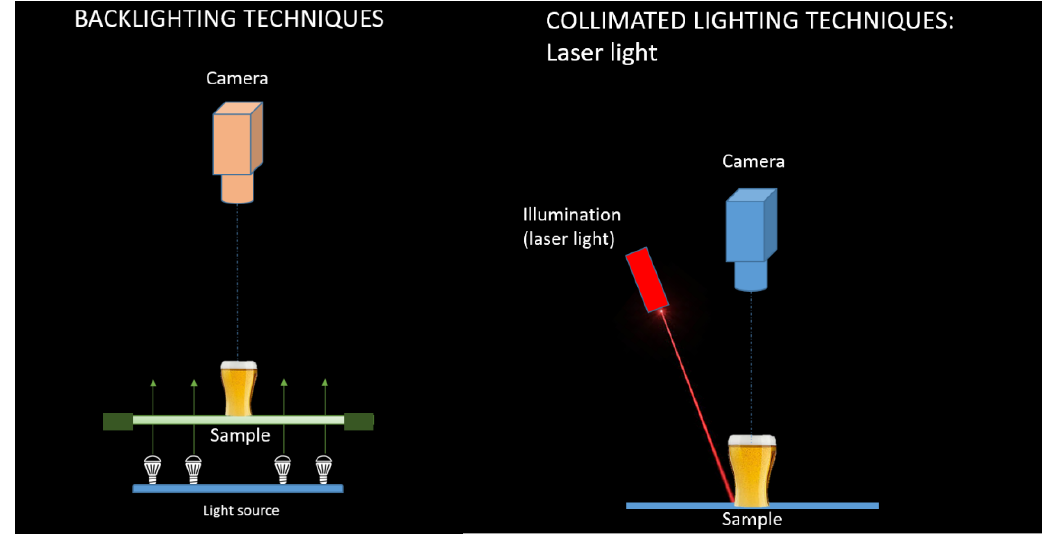
Figure 7. Shallowly lighting techniques—Dark field lighting.